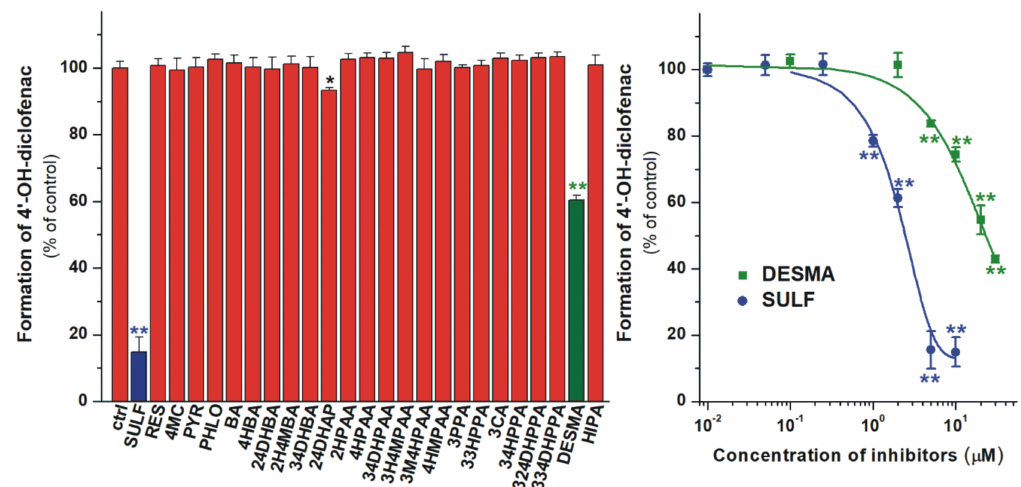
Figure 6. Left: Inhibitory e ff ects of colonic flavonoid metabolites and sulfaphenazole (SULF, positive control; 20 µ M each) on the CYP2C9-catalyzed diclofenac (5 µ M) hydroxylation. O -desmethylangolensin (DESMA) was the sole compound which considerably inhibited the enzyme. Right: Concentration-dependent inhibition of CYP2C9 by DESMA and SULF (* p < 0.05; ** p < 0.01). Means and SEM values demonstrated are derived from three independent